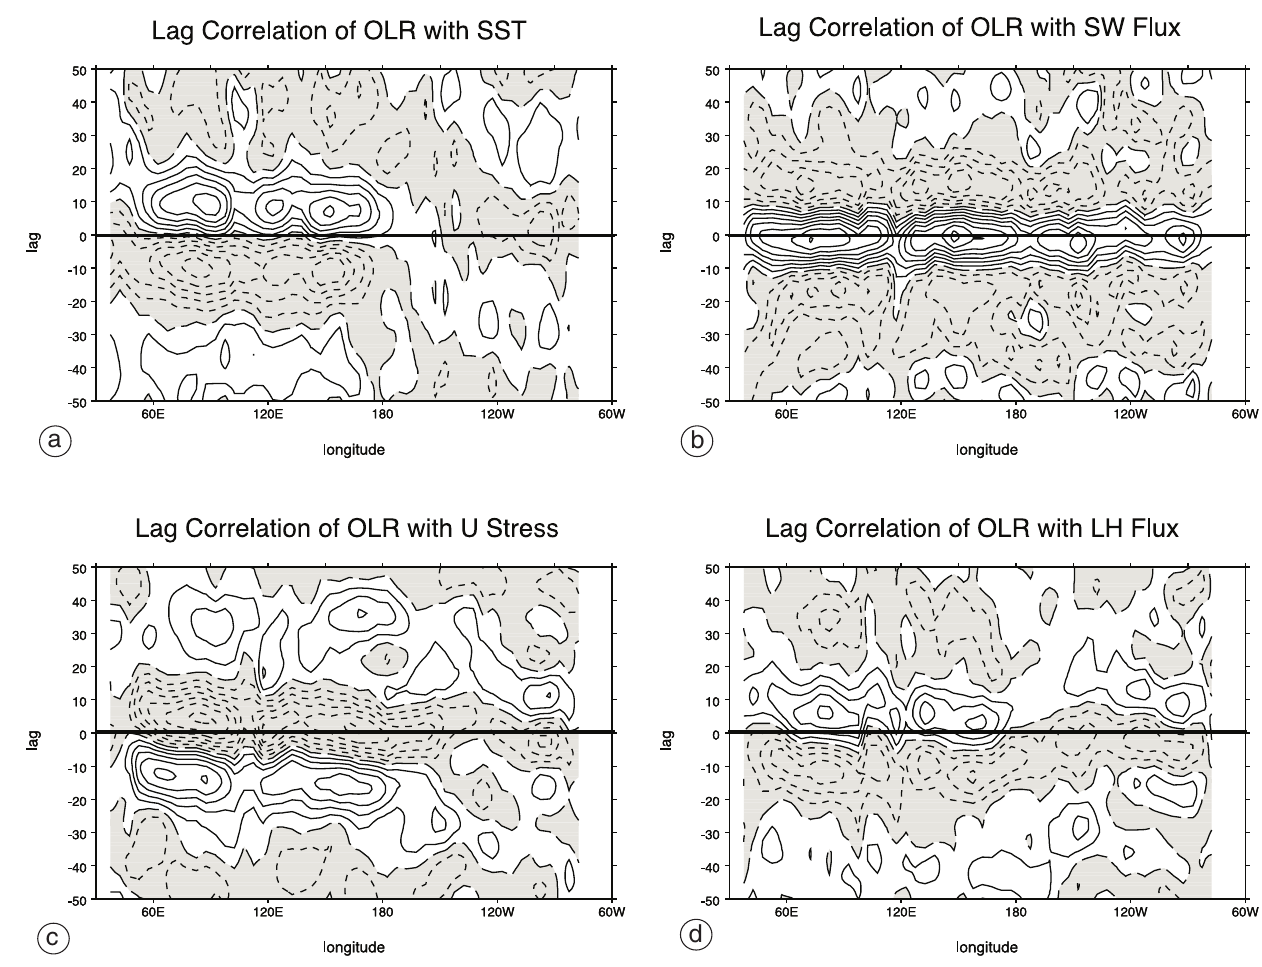
Fig. 8a-d. Lag correlations between observed OLR (convection) and surface fields: a) Sea Surface Temperature (SST); b) shortwave radiation; c) zonal wind stress, and d) latent heat flux. Negative lags indicate that the convection lags the surface field, positive lags indicates that the convection leads the surface fields. The sign convention is such that positive correlations indicate that enhanced convection (a negative OLR anomaly) is correlated with a negative SST anomaly, reduced shortwave radiation at the surface, enhanced evaporation or an easterly wind stress anomaly. From Woolnough et al.